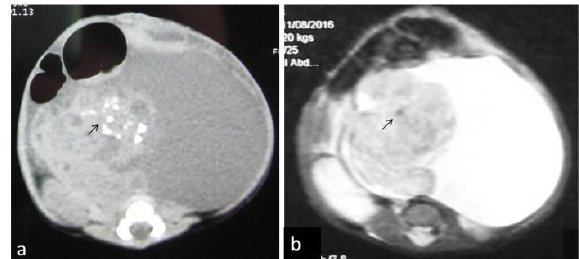
Figure 9: Imaging of predominantly cystic Sacrococcygeal tera- toma (C3) with abdominal extension in a 25-day-old female: a) CT scan; b) MRI axial T2WI. Note the superior demonstration of tumor calcification (black arrow) in (a) than